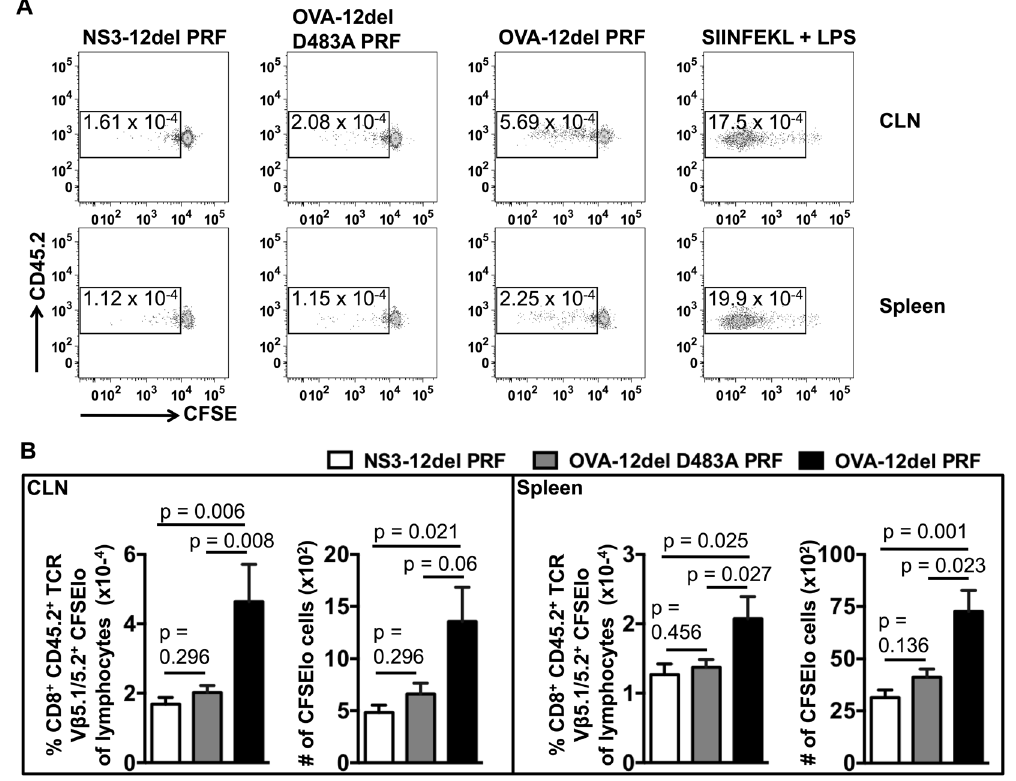
Figure 3. Cytolytic DNA immunisation enhances antigen presentation to CD8 + T cells in a time-dependent manner in vivo . ( A ) C57BL/6.SJL mice were immunised via the ID route with 100 μ g of NS3-12del PRF (n = 7), OVA-12del D483A PRF (n = 14) or OVA-12del PRF (n = 14) prior to i.v. transfer of 30 μ M CFSE-labelled C57BL/6 OT-I cells (5 × 10 6 cells/recipient) 7 days later. 15 days after the i.v. transfer, proliferation of OT-I CD8 + cells was measured in the CLN and spleens of recipient mice. As a positive control, one day after the adoptive transfer of OT-I cells into naïve recipient mice (n = 2), 20 μ g SIINFEKL peptide + 5 μ g of LPS were injected ID per mouse prior to analysis 14 days later. Representative dot plots gated on CD8 + CD45.2 + T cell receptor (TCR) V β 5.1/5.2 + are shown. The numbers in the gates indicate the percentage of lymphocytes that are single cells (doublet discriminated), CD8 + CD45.2 + TCR V β 5.1/5.2 + with reduced levels of CFSE. ( B ) Mean + SEM of the percentages indicated in A (left panel) and the mean + SEM of the absolute number of CD8 + CD45.2 + TCR V β 5.1/5.2 + CFSElo cells (right panel). Pooled data from two independent experiments are shown. The Kruskal- Wallis H test was used to determine the statistical significance of the